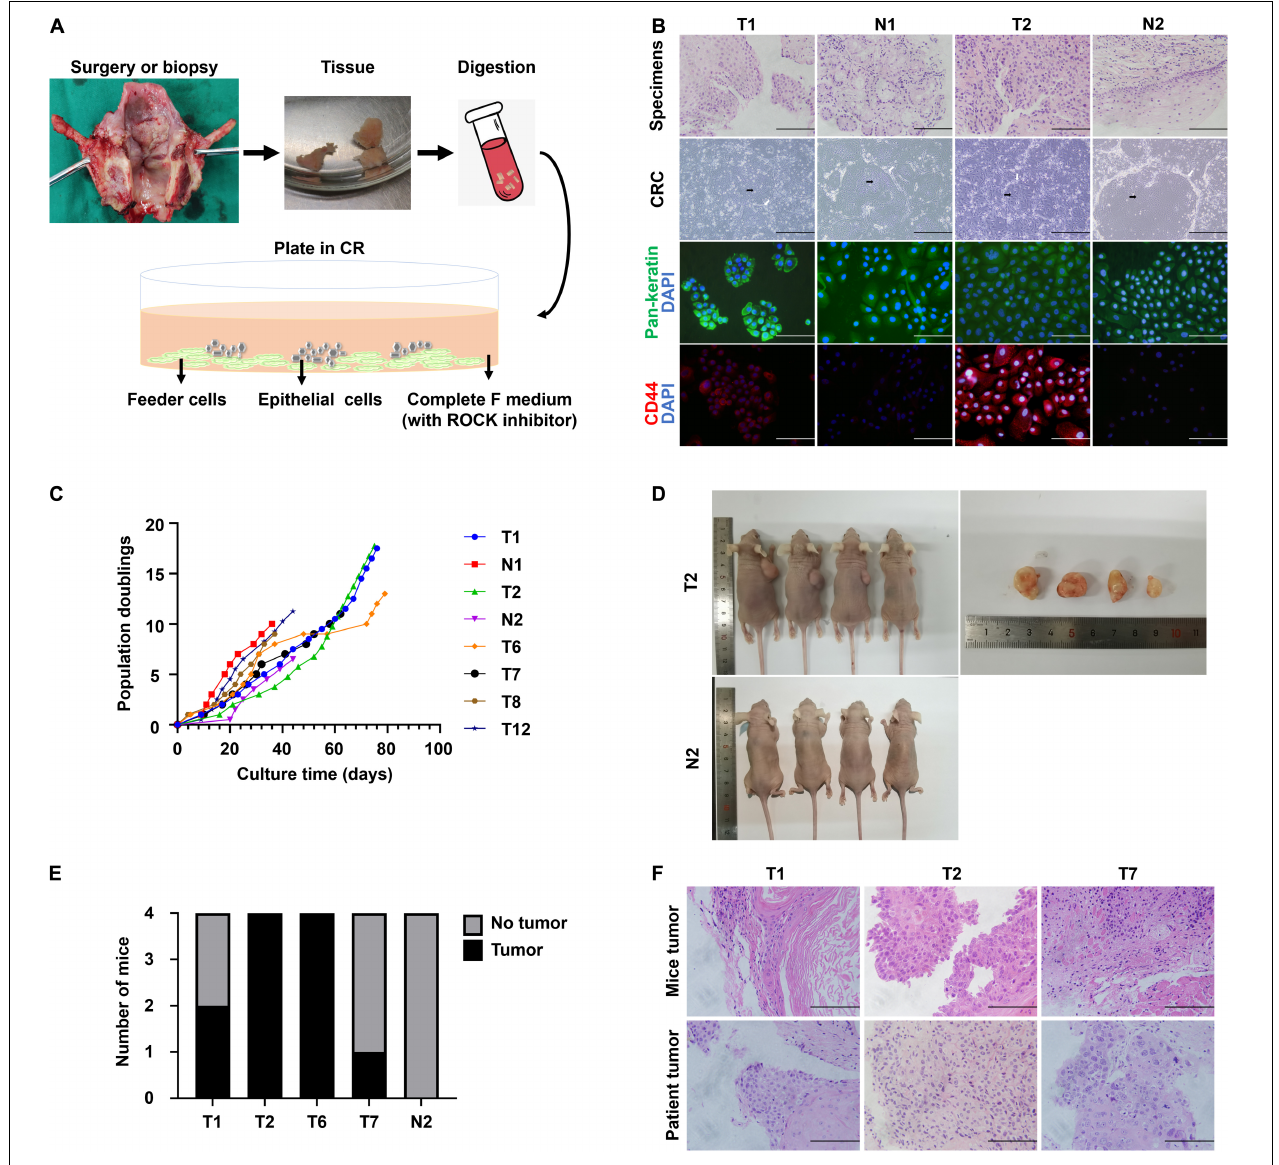
FIGURE 1 | The establishment of CR system from patient-derived tissues and the characteristics of CRC lines. (A) Schematic representation of the digestion and initial culture condition of CRCs. Tissue obtained via biopsy or resection was collected, minced, digested using trypsin, and subsequently inoculated. (B) Hematoxylin and eosin (H&E) staining of primary tissue of T1, N1, T2, and N2, bright-field microscopic images of the corresponding CRCs, and immunofluorescence for pan-keratin and CD44 markers of corresponding cell slides. Black arrow, conditionally reprogrammed cells. White arrow, feeder cells. Scale bars for HE staining and immunofluorescence images, 125 µ m. Scale bars for bright-field microscopy images, 500 µ m. (C) The CRC lines were passaged repeatedly and continued to proliferate with a steady growth rate. The cell number was recorded at each passage, and a plot of population doublings versus time (days) was constructed. (D) Representative images of mice bearing tumors and the dissected tumors were shown. (E) Four independent mice were injected subcutaneously with 4 tumor CRC lines and 1 normal CRC line, and the number of mice developing tumors was depicted. (F) Hematoxylin and eosin (H&E) stained images of mice tumors resembled those of the corresponding patient